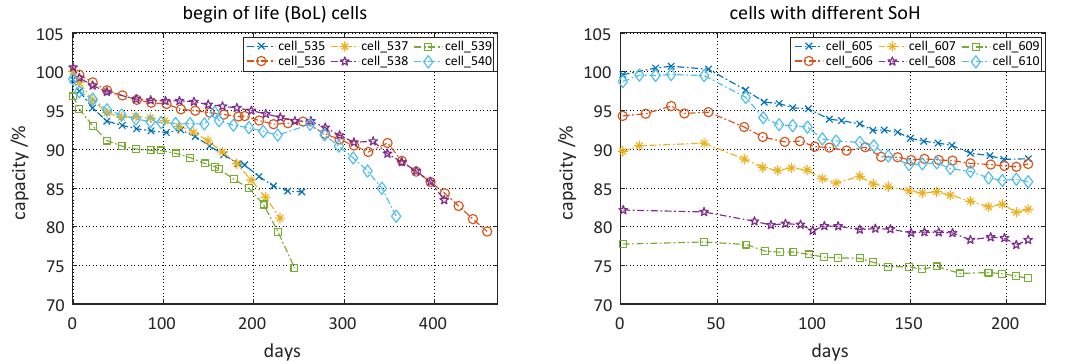
Figure 4. Capacity loss during cycling with a single HV1 ( left ) and various real-world load profiles (HV1-HV12) on the ( right )